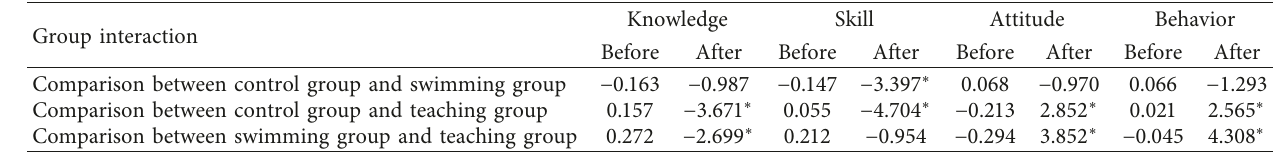
Table 2: Time and group interaction simple effect test results ( t -value). Group interaction